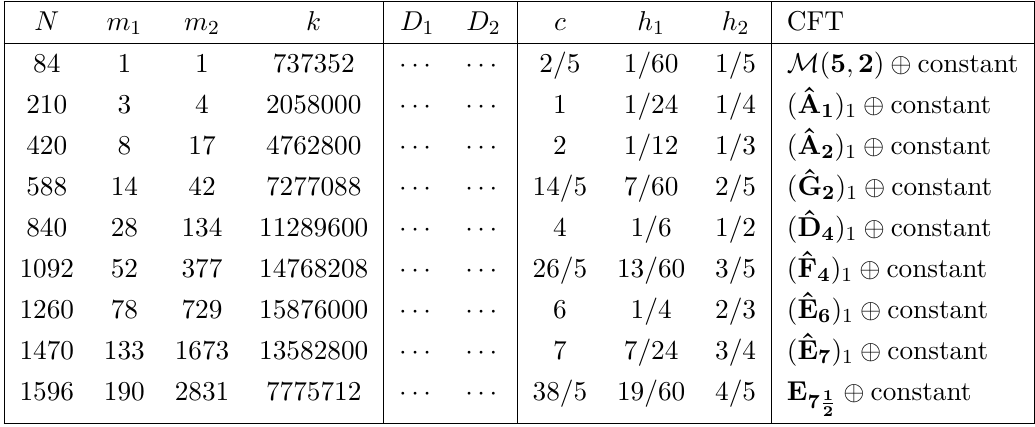
Table 19 . Solutions to the [ 3 , 2 ] MLDE with 0 < c ≤ 96